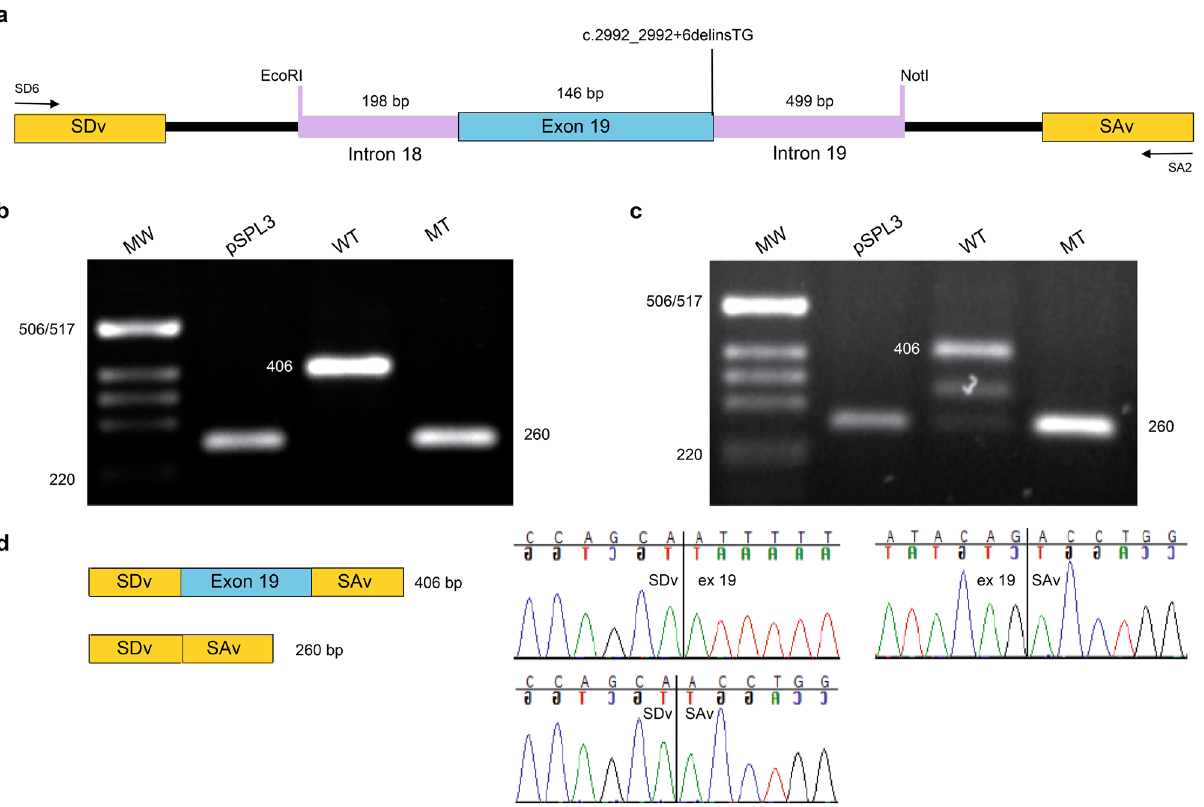
Figure 1. Exon skipping because of EYS c.2992_2992+6delinsTG variant. ( a ) A schematic illustration of the pSPL3- EYS c.2992_2992+6delinsTG minigene. Exon 19 of EYS gene (blue) and flanking introns (purple) were cloned into the pSPL3 vector (black) with a wildtype (wt) or mutant (mt) c.2992_2992+6delinsTG between two pSPL3 exons (yellow); splice donor vector (SDv) and splice acceptor vector (SAv). Positions of SD6 and SA2 primers for splice analysis are displayed. HEK293T cells and ARPE-19 cells were transfected with wt or mt EYS hybrid minigene or an empty pSPL3 vector. After RNA extraction and cDNA synthesis, splicing products were amplified by PCR using SD6 and SA2 vector specific primers and visualized by agarose gel electrophoresis. Resolution of splicing PCR products derived from HEK293T are shown in ( b) and from ARPE-19 in ( c) . Sanger sequencing confirmed that in the control pSPL3, only SDv-SAv splicing occurred, leading to a 260 bp product. Expected wt splicing of the EYS minigene was a 406 bp product. In ARPE-19 cells, an additional band ~ 320 bp of unknown sequence was visible for the wt. In both HEK293T and ARPE-19 cells, the mt hybrid minigene resulted in exon skipping ( d ). Full-length gels are presented in Supplementary Figure